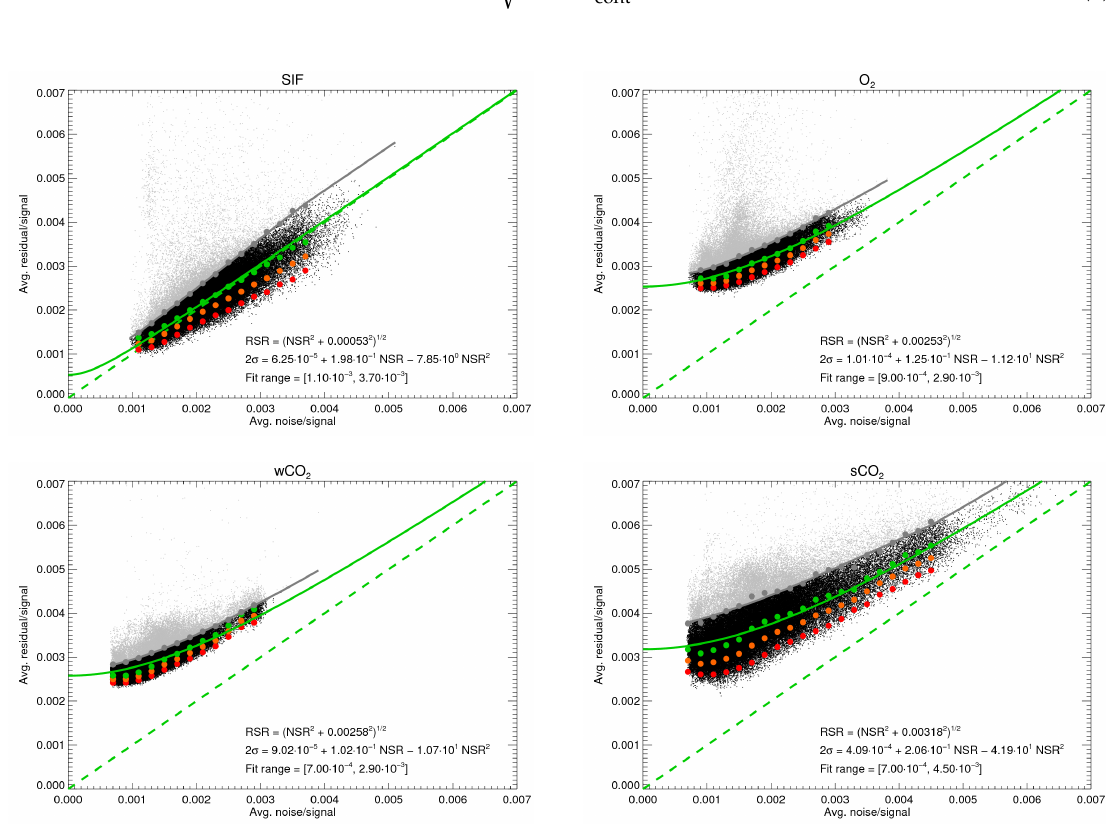
Figure 4. Root mean square noise to signal ratio NSR versus root mean square residual to signal ratio RSR for all four fit windows. red points : 2.28th percentile within bins with more than 500 samples (35 bins in total). orange points : 15.9th percentile. green points : expectation value estimated from the 2.28th and 15.9th percentile. solid green line : RSR as computed from the RSR model (Equation (1)). gray points : RSR model plus 2 σ estimated from the 2.28th and 15.9th percentile. gray line : outlier threshold. gray dots : potential outliers. dashed green line : one-to-one